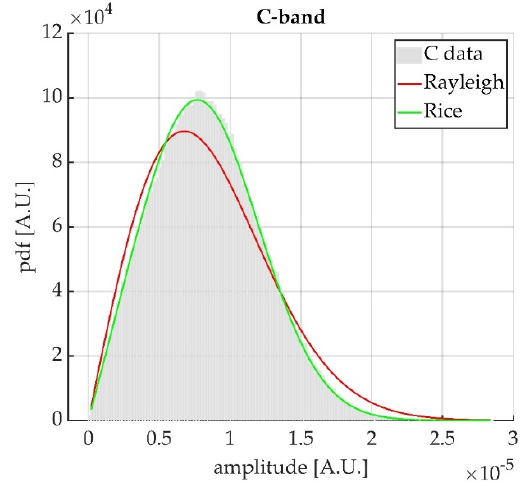
Figure 4. Histogram of the signal amplitude values of the GBSAR image, compared with theoretical Rayleigh (red curve) and Rice (green curve) distributions.